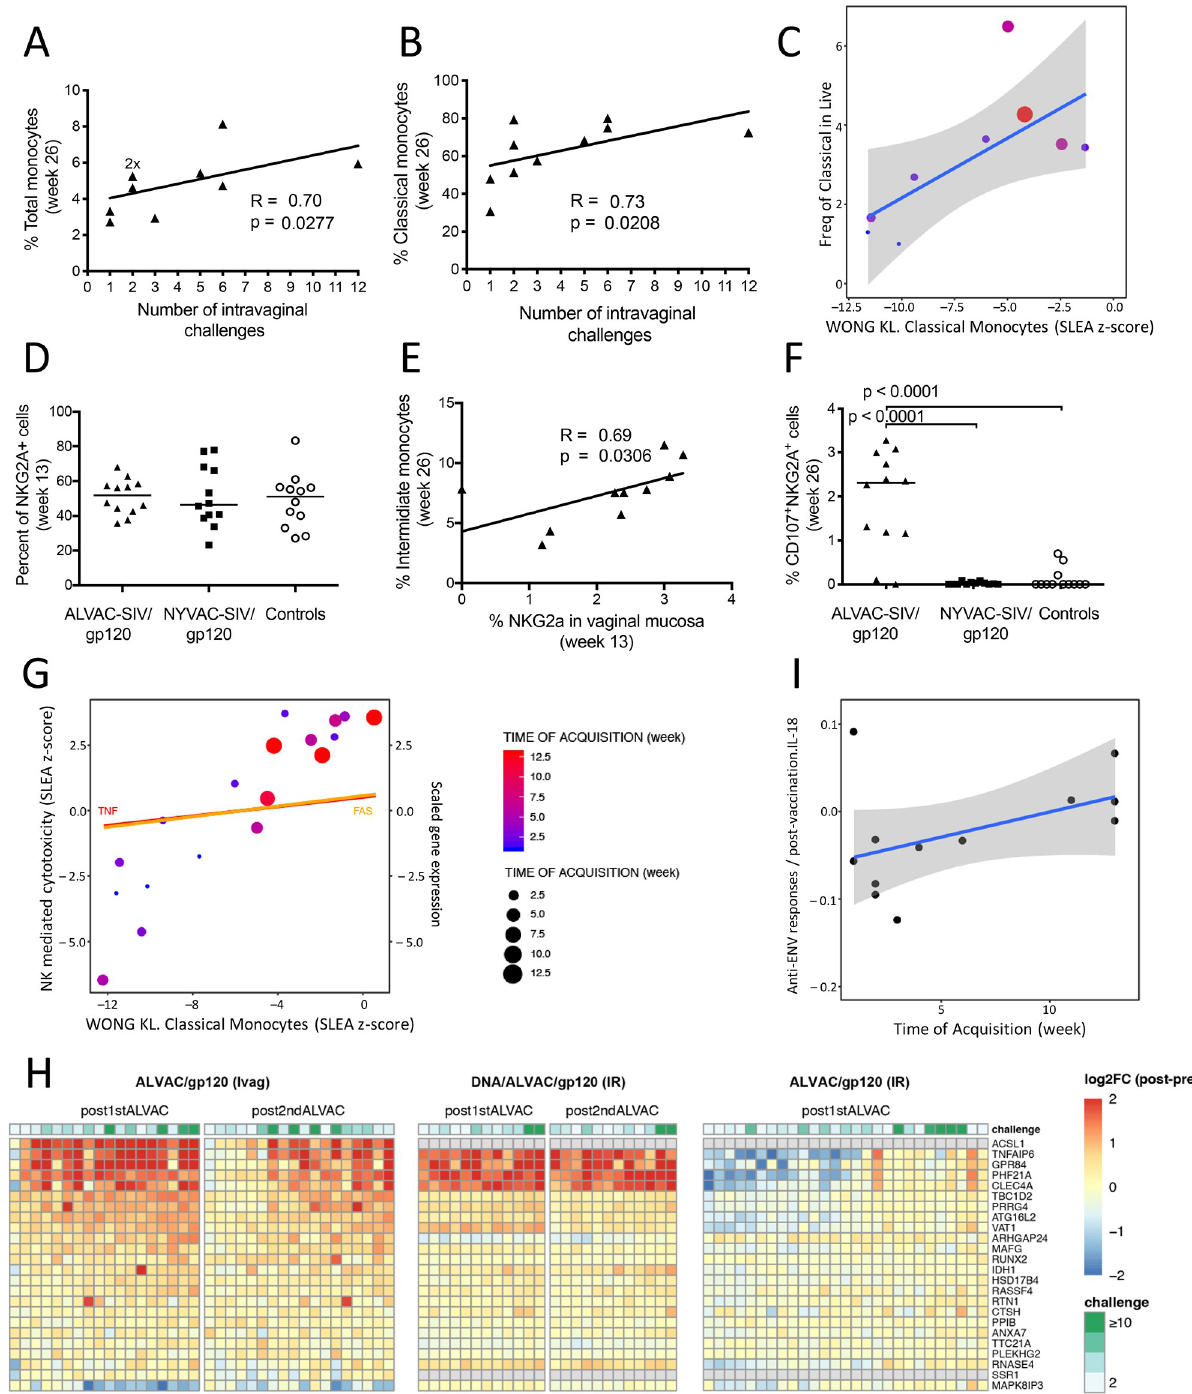
Fig 2. Monocytes and NKG2A cells in risk of SIV mac251 acquisition. Pearson correlation of myeloid cell subsets with SIV mac251 acquisition in the ALVAC-SIV group. The levels of myeloid cells were analyzed only from animals in Part 2 (Table 1 ). (A) The percentage of total monocytes and (B) CD14 + CD16 - classical monocytes were associated with decreased rate of SIV acquisition. (C) GSEA analysis of the transcriptomic profile of the ALVAC-SIV/gp120 animals at week 26 revealed an enrichment of classical monocyte markers among genes associated with lower risk of SIV acquisition. The SLEA method was used to summarize classical monocyte markers for each subject. A scatterplot shows average classical monocyte markers as a function of the frequency of classical monocytes measured by FCM in ALVAC-SIV treated animals at week 26. The grey region indicates the 95% confidence-interval of this correlation. (D) Relative frequency of NKG2A cells (defined as CD45 + , CD3 - , CD20 - , and CD14 - cells) at week 13